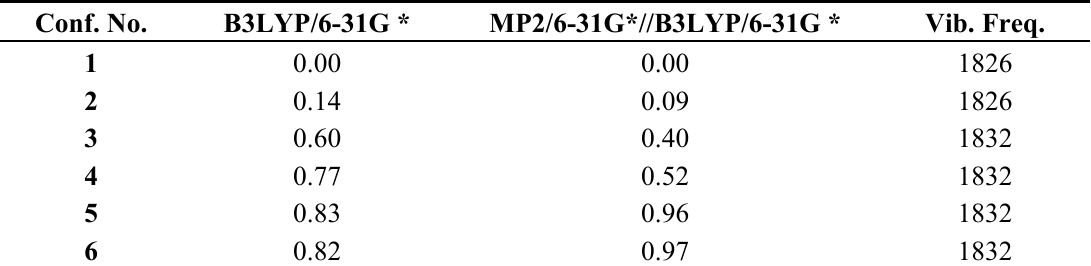
Conf. No. is the conformation number and Vib. Freq. is the vibrational frequency in cm –1 . Energy of conformation 1 at the B3LYP/6-31G* level is –885.10862 au and at the MP2/6-31G*//B3LYP/6-31G* level it is –882.29213